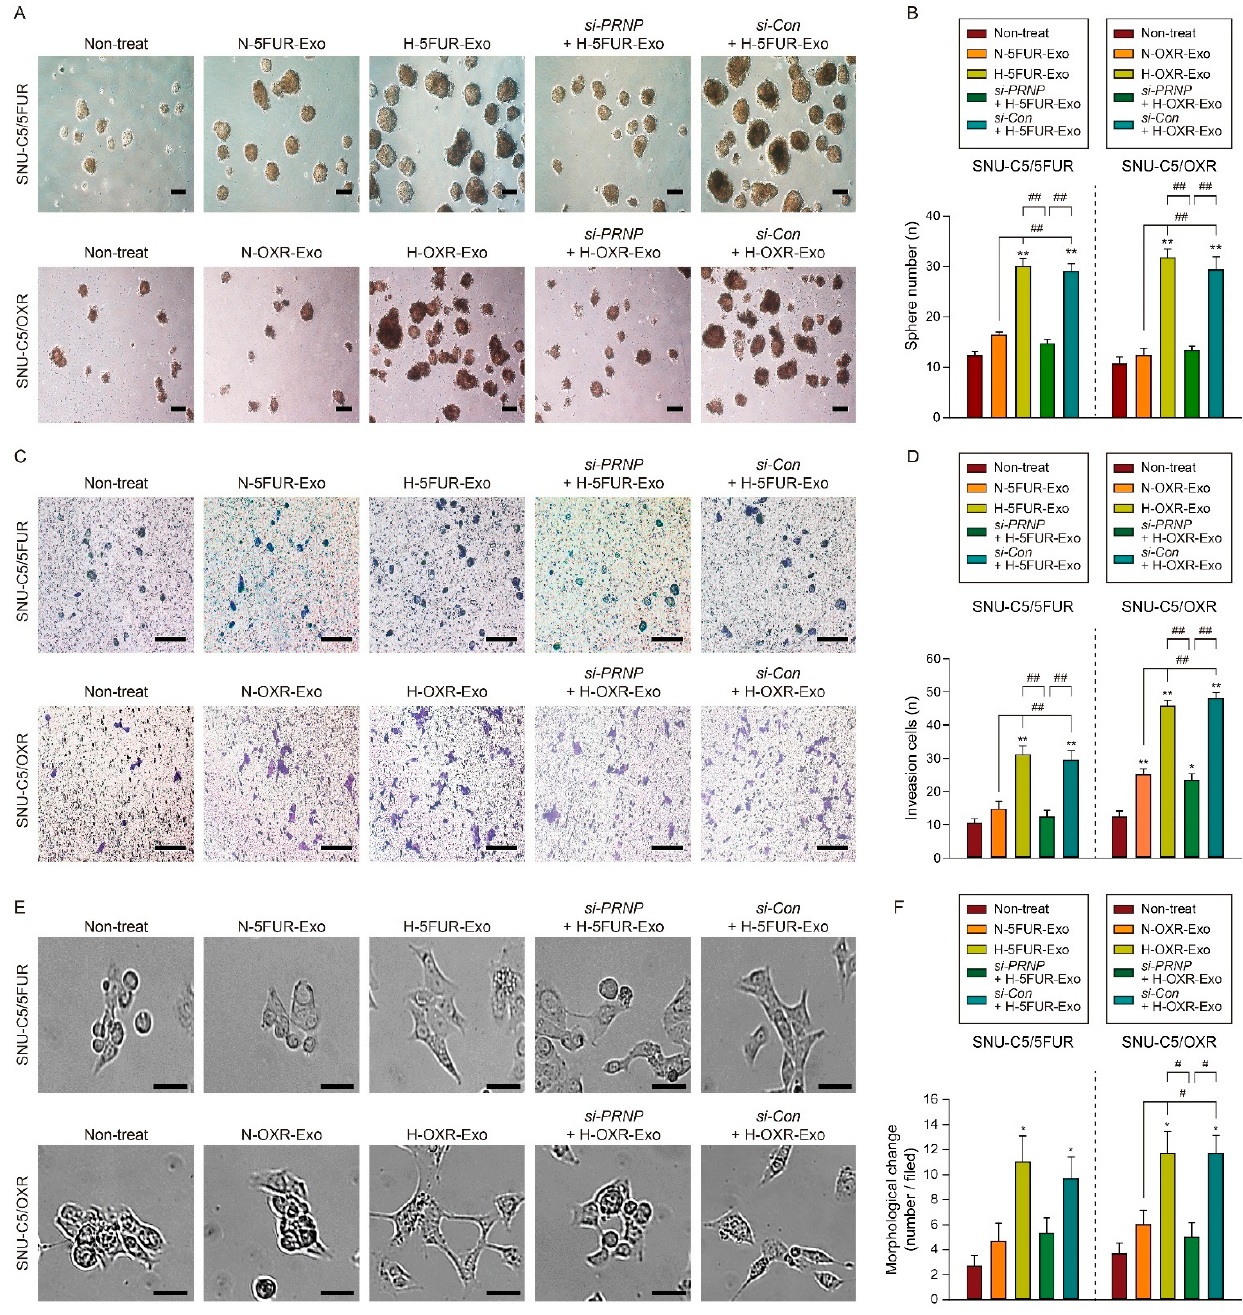
Figure 4. Effect of exosomes secreted by hypoxic 5FU-resistant CRC cells on tumorigenesis. ( A ) Sphere formation assay of SNU-C5/5FUR and SNU-C5/OXR treated with exosomes isolated from SNU-C5/5FUR and SNU-C5/OXR under normoxic and hypoxic conditions. Scale bar = 200 µ m. ( B ) Quantification of the number of spheres is shown as a bar graph (n = 3). ( C ) Representative invasion analysis is shown as a scale bar = 200 µ m. ( D ) The average number of invasive cells is shown as a bar graph (n = 3). ( E ) Representative morphological change analysis of SNU-C5/5FUR and SNU-C5/OXR treated with exosomes isolated from SNU-C5/5FUR and SNU-C5/OXR under normoxic and hypoxic conditions. Scale bar = 50 µ m. ( F ) The average number of morphologically changed cells is shown as a bar graph (n = 3). Data are presented as the mean ± SEM. * p < 0.05, ** p < 0.01 vs. non-treatment; # p < 0.05, ## p < 0.01